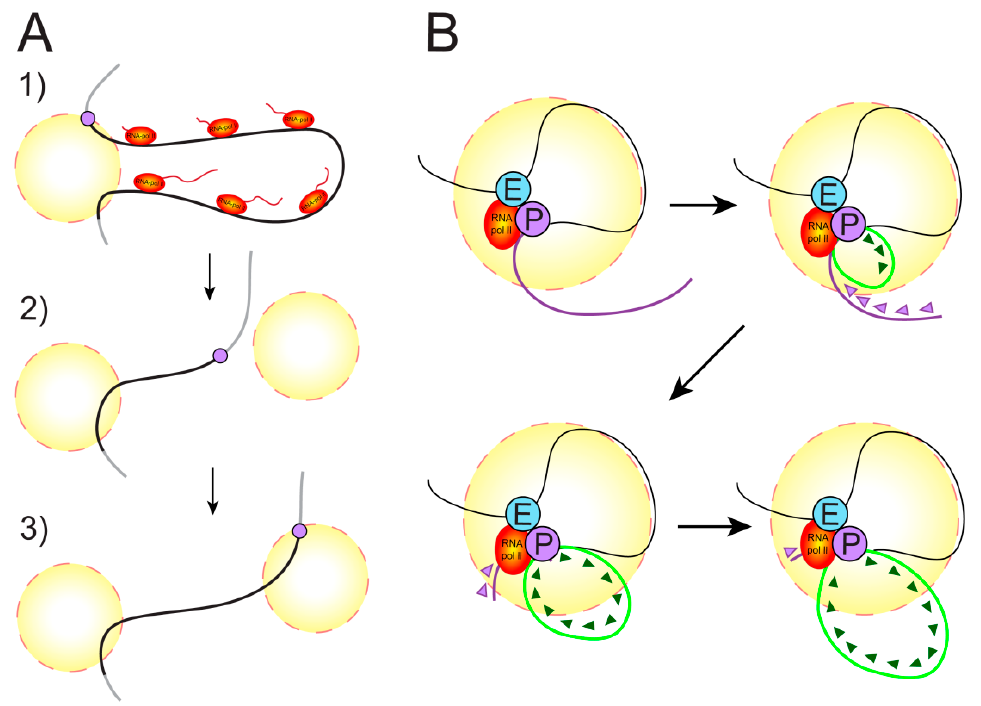
Figure 2. Spatial organization of the gene body within a transcription factory (yellow circle). ( A ) The organization of a factory for extended genes is presented. Genes occurring in such a factory form the so-called gene loops, when the beginning of the gene and its end somehow become anchored in the factory [15]. In this case, the gene looks similar to a loop of chromatin. Pol II molecules move along the gene one after another, reading the gene. A gene can be disconnected from the factory, and re-initiation can occur in another factory, where the tail of the gene is subsequently pulled [7,42]. ( B ) An alternative form of transcription organization for extended genes is presented. The gene enhancer and promoter are brought together and possibly are in a complex. Moreover, part of the gene is located inside the factory, and part of the gene is located on the surface of the factory or is partly reeled on it [41]. The Pol II molecule is immobilized in the factory, and the gene body is pulled through it in the form of a loop formed [43]. The spatial organization of transcription for short genes in a transcription factory was not studied because of technical limitations and may proceed according to either of the two presented scenarios [43].